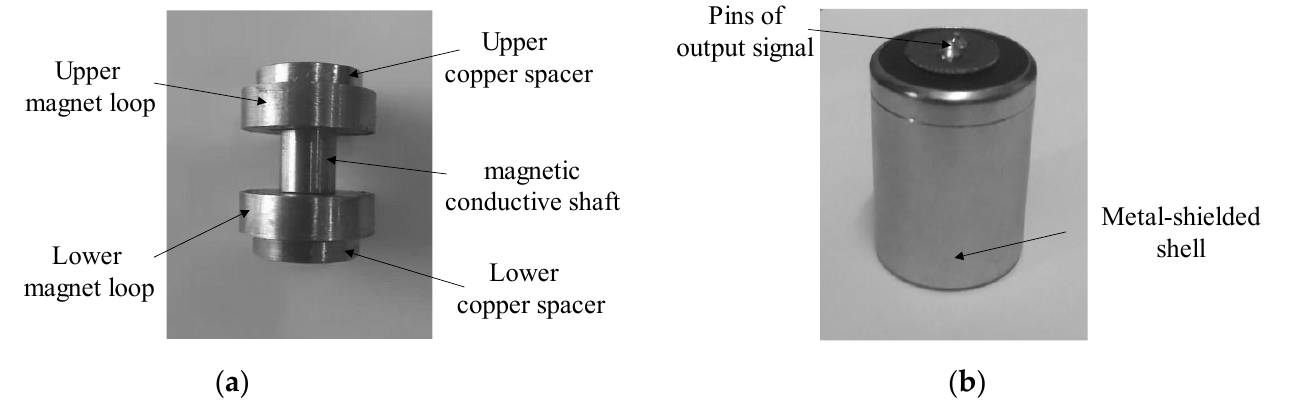
Figure 15. The actual picture of the DM sensor. ( a ) Assembly consisting of copper spacers, magnet loops, and magnetic conductive shaft; ( b ) outlook of DM sensor.